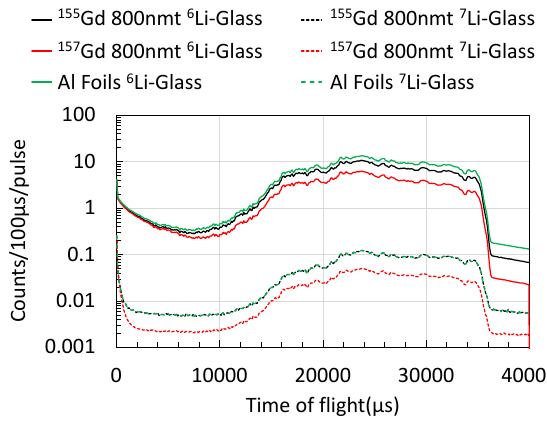
Figure 5. TOF spectra of the 155 Gd and 157 Gd samples and the Al foils with 6 Li-glass and 7 Li-glass detectors. Each TOF spectrum was normalized with the number of proton beam pulses.